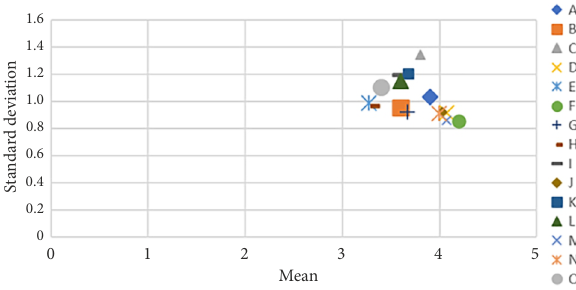
Figure 4. Scatter plot of mean and std.